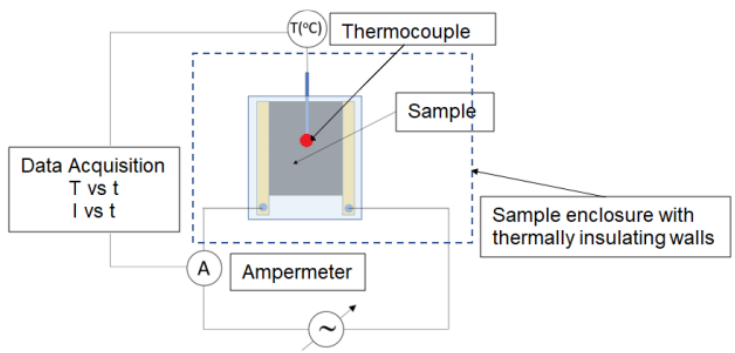
Figure 2. Schematic setup for T s vs. time and I vs. time measurements. A typical curve of ρ vs. T upon heating, with the parameters characterizing the kinetics of the process is shown in Figure 3. The cooling curve has similar shape, but is inversed, due to temperature decrease.